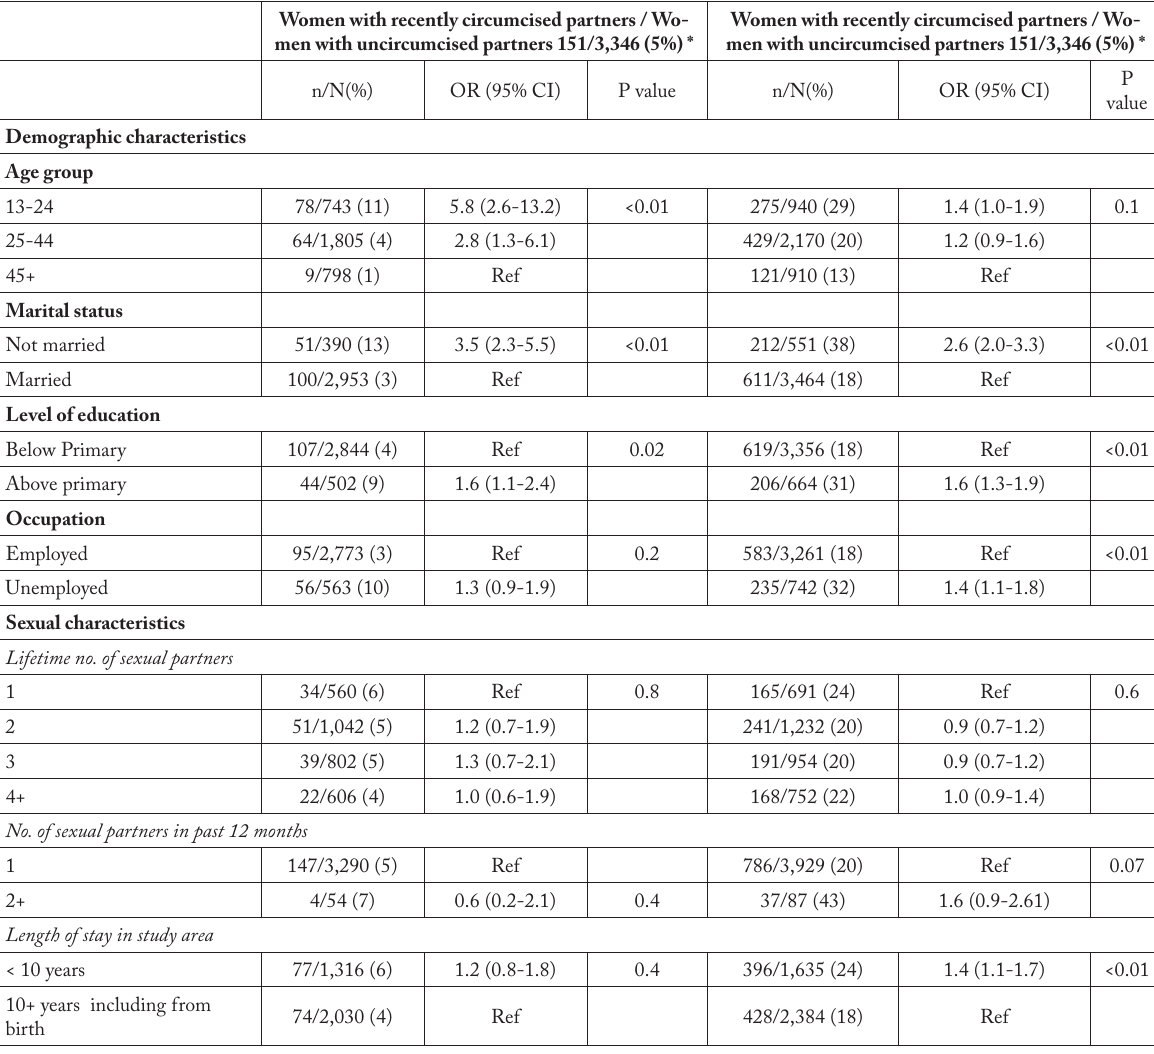
Table 4. Factors associated with circumcision status of primary partners of female respondents by timing of circumci- sion status, Siaya County, Western Kenya, 2012-2014 (All women: n =